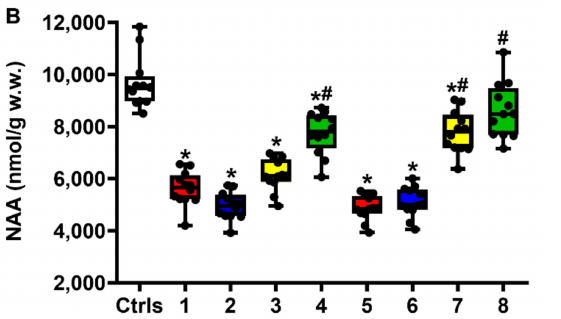
Figure 5. The box plots reporting all data points ( • ), minimum, maximum, median, 25 and 75 percentiles of Asp ( A ) and NAA ( B ) in rats without and with the s.c. administration of in- creasing ILB ® doses (1, 5 and 15 mg/kg b.w.). Ctrls = control sham-operated rats; 1 = sTBI only, sacrificed at 2 days post-injury; 2 = sTBI + 1 mg/kg b.w. ILB ® , sacrificed at 2 days post-injury; 3 = sTBI + 5 mg/kg b.w. ILB ® , sacrificed at 2 days post-injury; 4 = sTBI + 15 mg/kg b.w. ILB ® , sacrificed at 2 days post-injury; 5 = sTBI only, sacrificed at 7 days post-injury; 6 = sTBI + 1 mg/kg b.w. ILB ® , sacrificed at 7 days post-injury; 7 = sTBI + 5 mg/kg b.w. ILB ® , sacrificed at 7 days post-injury; 8 = sTBI + 15 mg/kg b.w. ILB ® , sacrificed at 7 days post-injury. * Significantly different from controls, q < 0.05. # Significantly different from corresponding time of untreated sTBI rats, q <